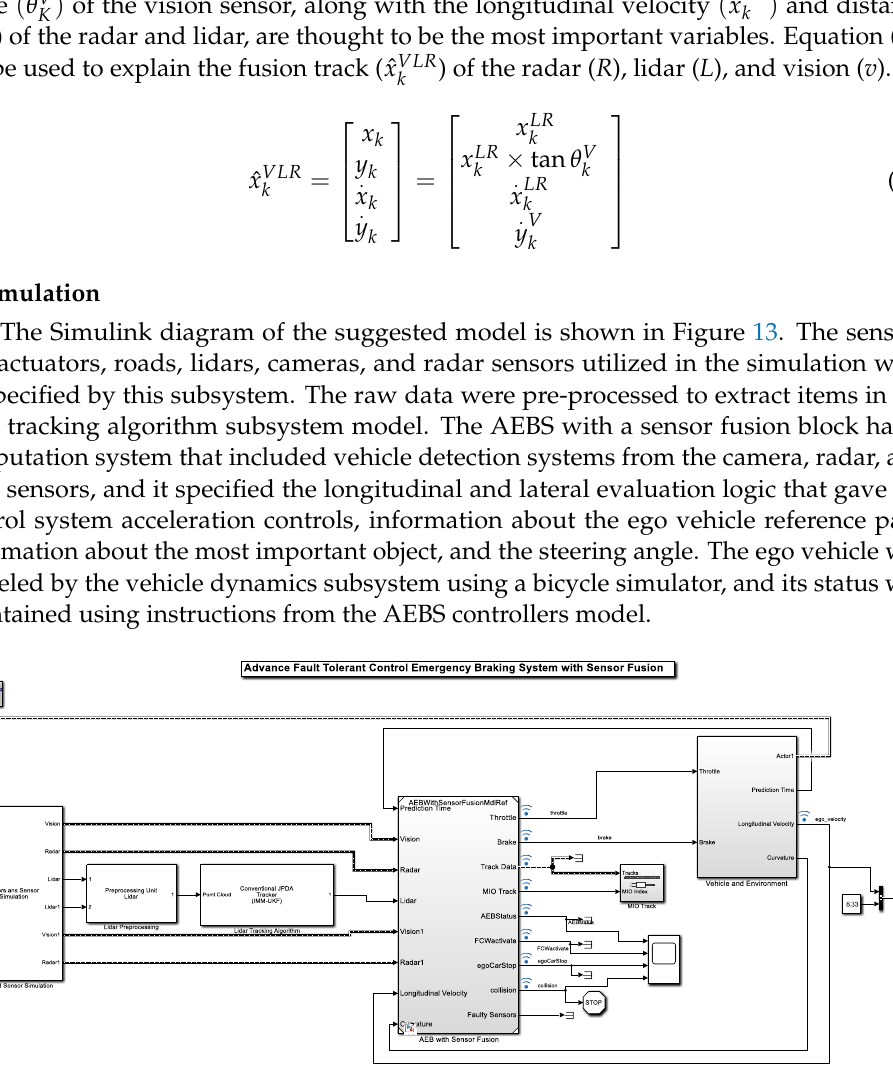
Figure 13. The advanced emergency braking system with sensor fusion.